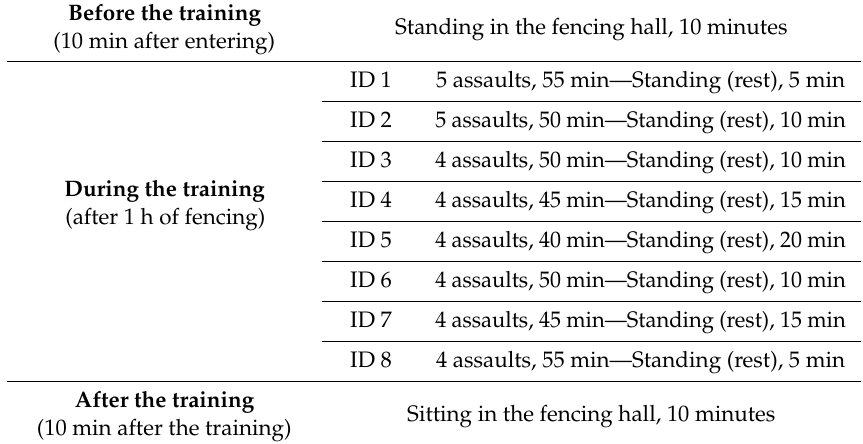
Table 3. Activities carried out by eight fencers during the training. The resting time during the training is considered as the total amount of rest between di ff erent assaults. Before the training